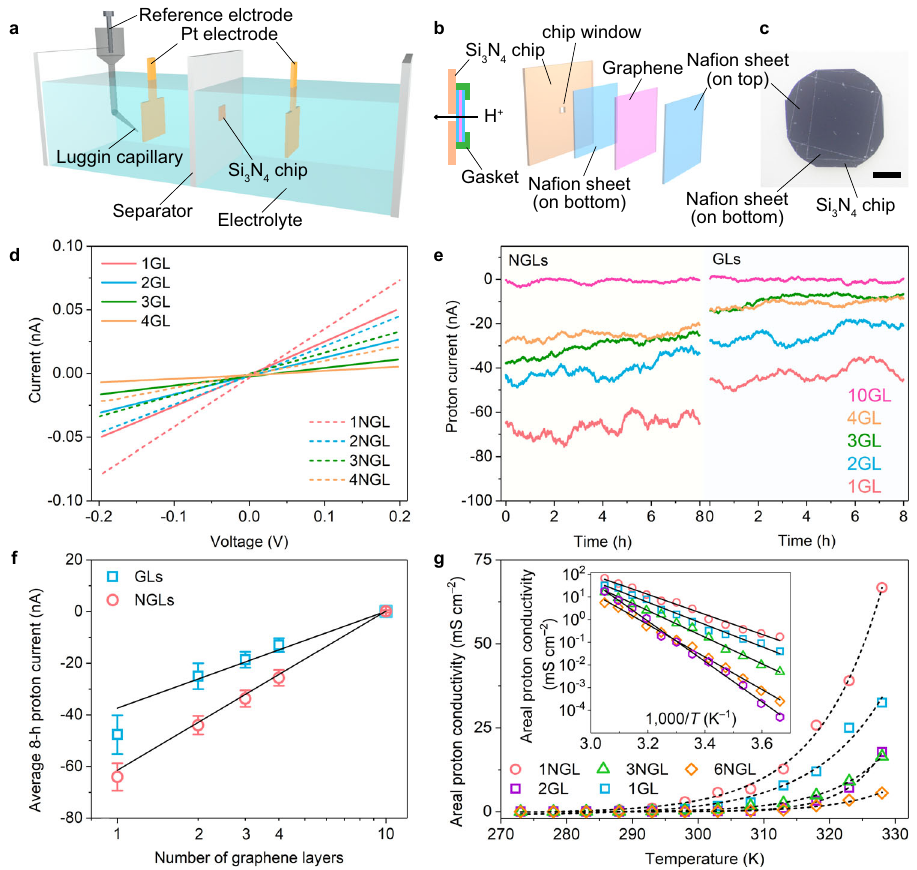
Fig. 3 H-type cell fabrication and electrochemical data for proton penetration through graphene layers. a Schematic of the H-type cell. b Placement of a stacked Na fi on/graphene/Na fi on sandwich membrane over the window area of a Si 3 N 4 chip. Na fi on acts as a protective sheet for graphene layers with high proton conductivity, chemical/electrochemical stability, and extremely low electron conductivity 43 . All gaps and points of connection were sealed by an acid-stable, ion-impenetrable gasket to ensure that protons could only pass through the graphene on the window area. c Optical photographic image of the Si 3 N 4 chip with an attached Na fi on/graphene/Na fi on sandwich. d I – V characteristics of the proton penetration through non- and N-doped graphene membranes with one to four layers. The solid and dashed curves represent the proton currents observed through GLs and NGLs, respectively. e Proton currents collected by CA at a cathode potential of − 20 mV vs. RHE through the GLs and the NGLs. f Average proton currents collected during 8 h of CA testing. Error bars show the fl uctuations in the measured signals. g Temperature dependences of proton conductivity for 1GL, 2GL, 1NGL, 3NGL, and 6NGL. Inset of ( g ): log σ as a function of T − 1 . The solid and dashed curves represent the fi ts to the experimental